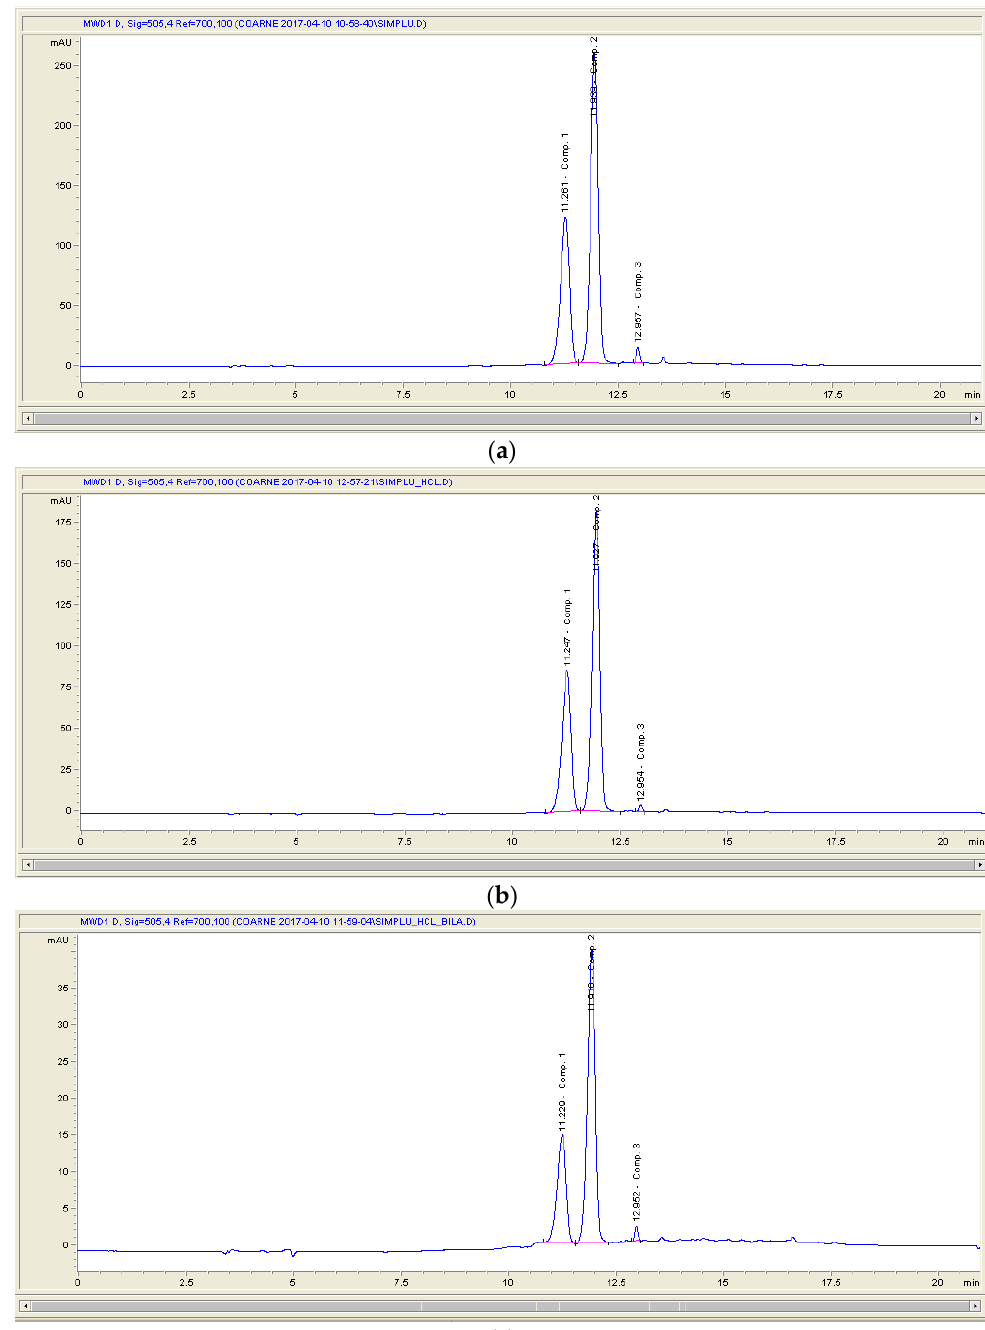
Figure 2. HPLC chromatograms (520 nm) of Cornelian cherries’ anthocyanins before and after in vitro digestion: ( a ) crude extract; ( b ) gastric digestion; ( c ) intestinal digestion.